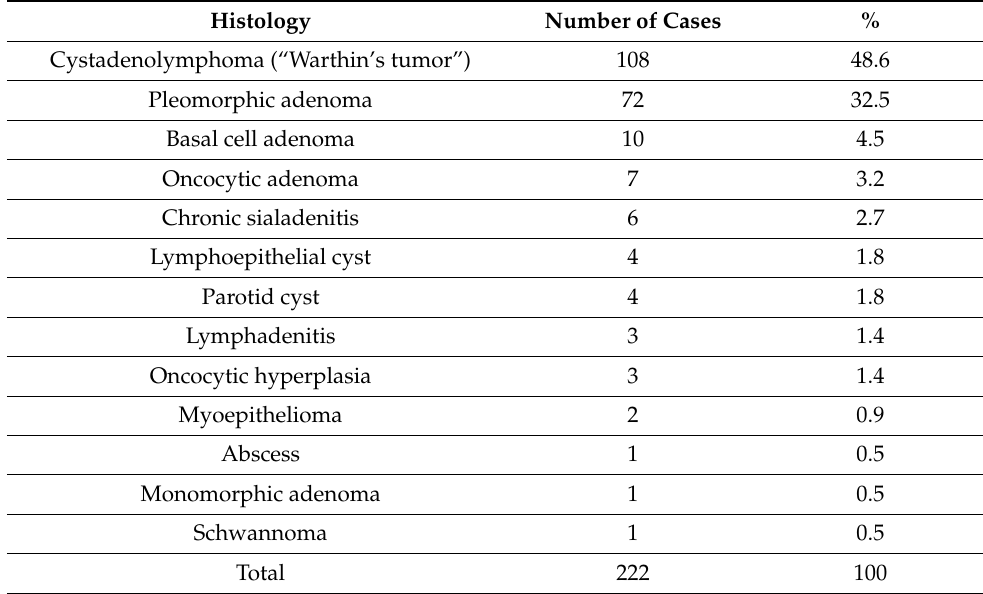
Table 1. Histology of the benign tumors of our study sample.